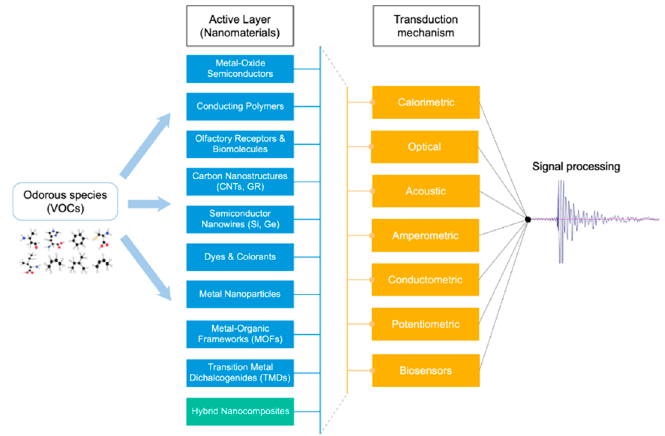
Figure 1. General framework with the di ff erent families of gas sensors that exist for the monitoring of VOCs. Gas sensors can be classified according to two basic principles: (i) the functional materials used to interact with the di ff erent compounds or (ii) the transduction mechanism employed for